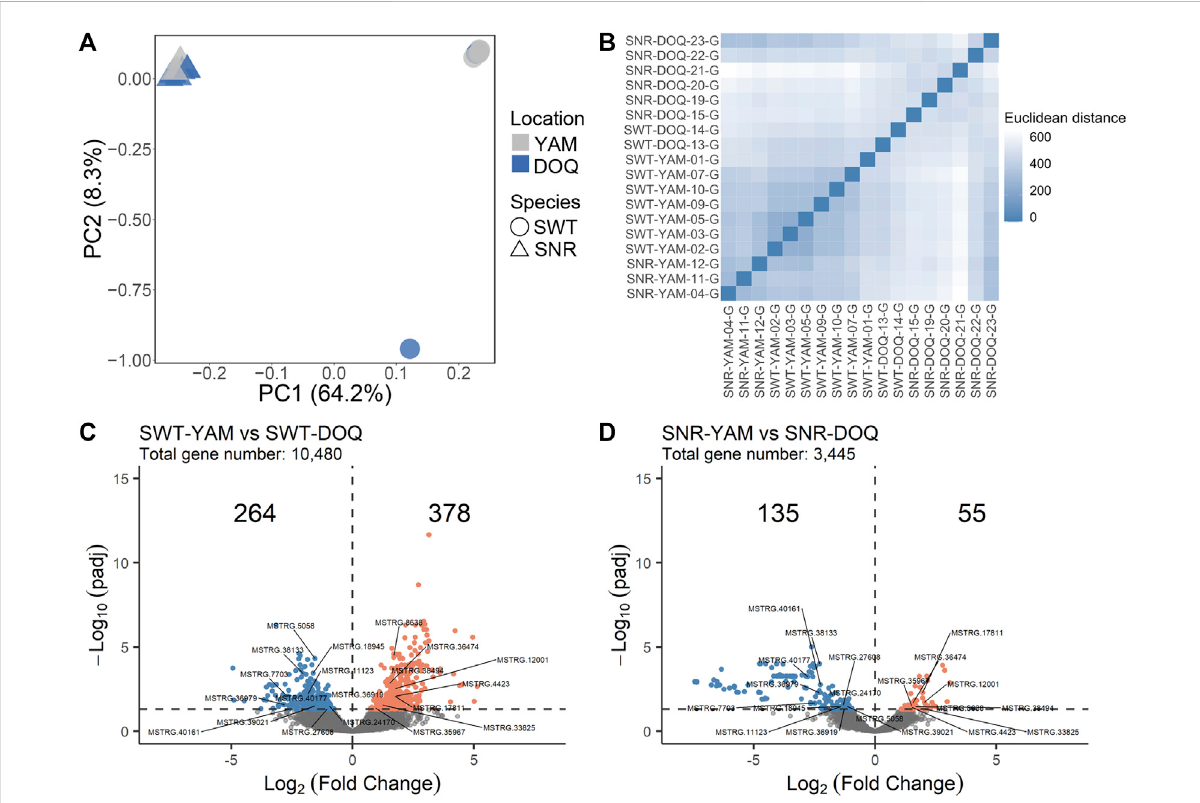
FIGURE 3 (A) PCA of four populations using SNPs called from RNA-seq data. (B) Euclidean distances among RNA-seq samples calculated using the gene count matrix after DESeq2 correction for library differences and rlog-transformation. (C,D) Volcano plots showing DEGs between Lake Yamzhog Yumco and Lake Doq ē n Co populations of T. stewarti (C) and T. stenura (D) . The number of genes upregulated (orange dots) and downregulated (blue dots) in Lake Yamzhog Yumco populations are marked. The 20 gene IDs labeled are common DEGs between the two